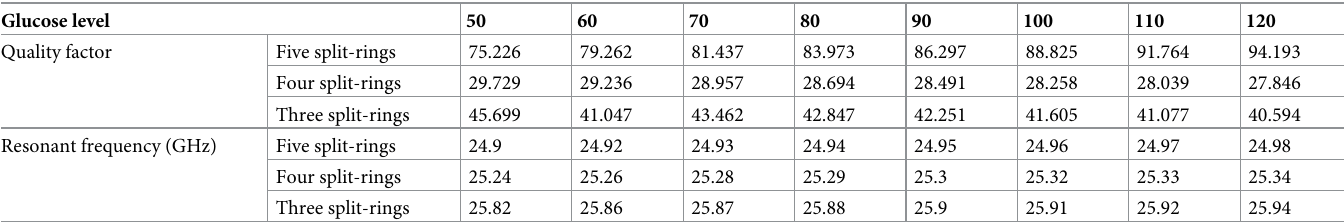
Table 2. Quality-factor and resonant frequencies on different glucose levels.